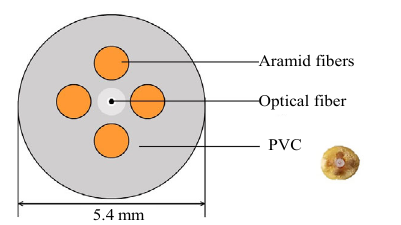
Fig. 43 Structure and cross-sectional photograph of the sensitivity-enhanced